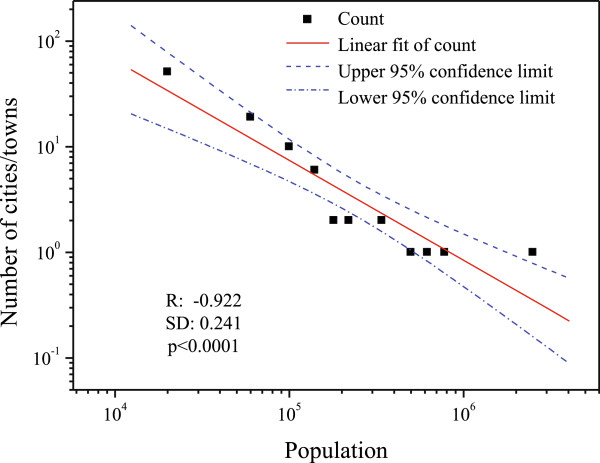
Population distribution across cities/towns in Ontario. The city/town population in Ontario follows a power-law distribution (correlation coefficient R=-0.922, standard deviation SD=0.2441, p <0.0001) as shown in this figure. This figure also reveals that our selected cities/towns (with population larger than 40,000) cover a major part (approximately 90.72%) of Ontario’s population.